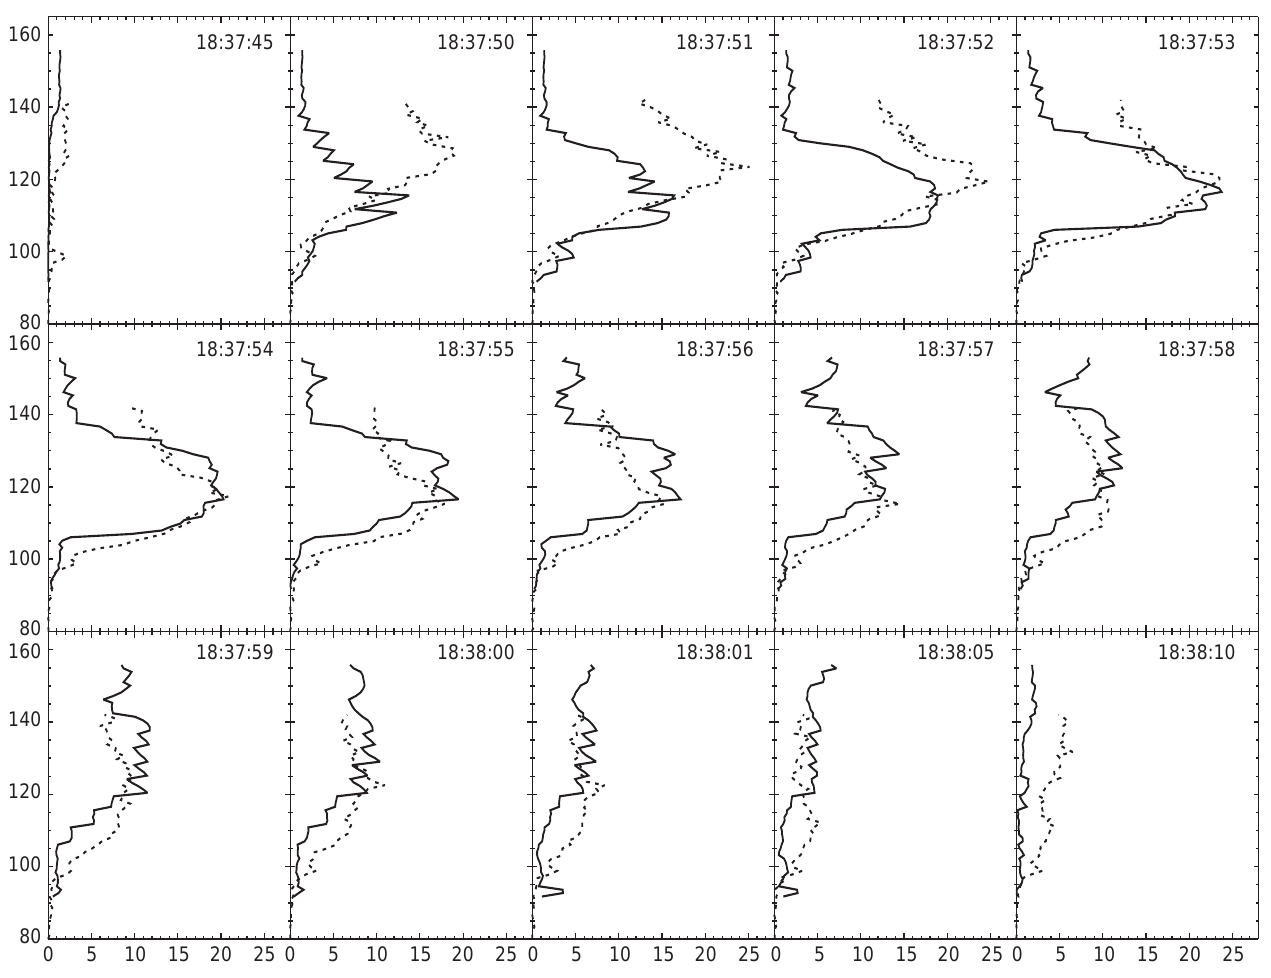
Fig. 6. Electron density profiles measured by the EISCAT PULSE program when the auroral arc crossed through the radar beam ( dotted line ) in units of 10 11 m (cid:255) 3 and the calibrated reconstructed profiles ( solid line ). The left axis shows the altitude in km. The profile at